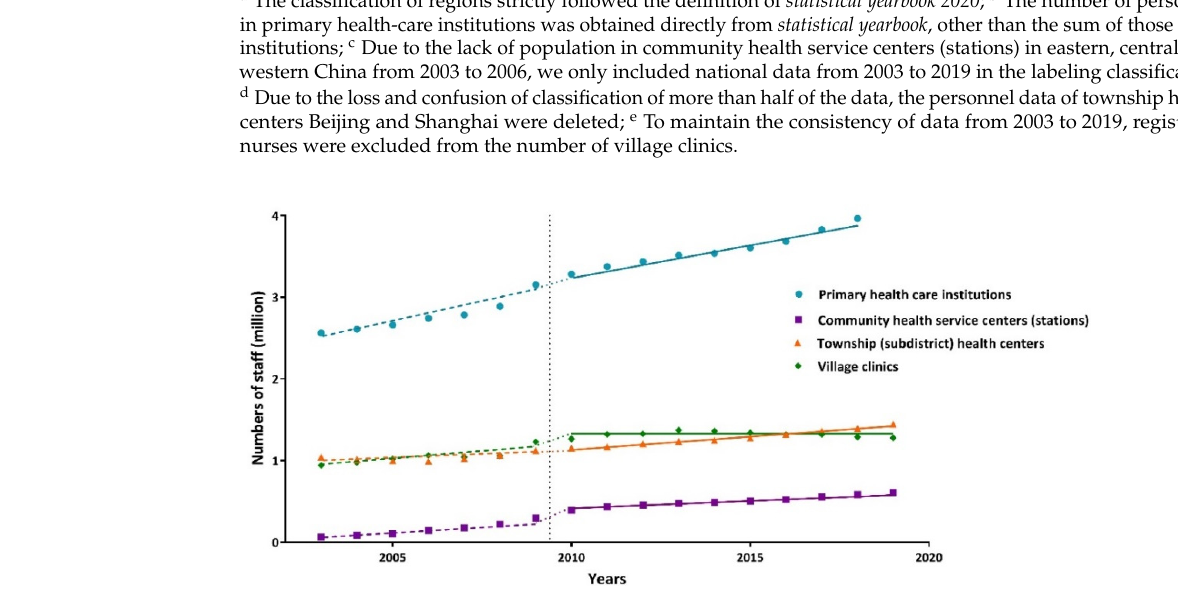
Figure 2. Interrupted time series analysis of human resources in various primary health-care institutions in China from 2003 to 2019.